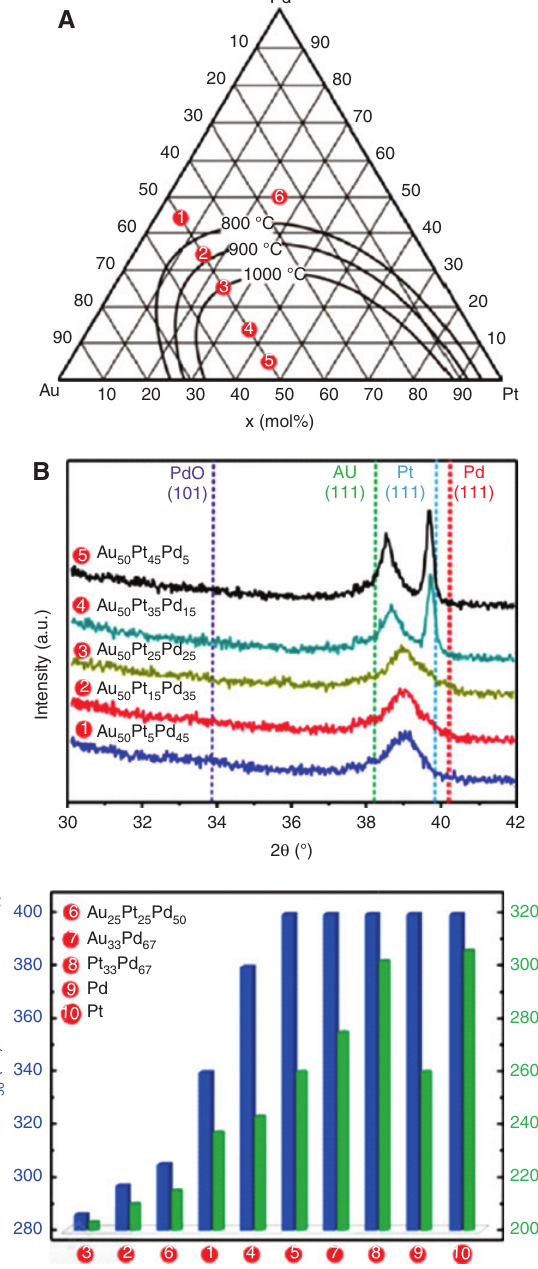
Figure 10: (A) Immiscible area isotherms of the bulk Au-Pt-Pd phase diagram. (B) XRD patterns of samples 1–5 annealed at 800 ° C. (C) The reaction temperatures for 50% ( T n -hexane for samples 1–6 (1 wt.%) and 7–10 (4 wt.%). Reproduced from [91] with permission from the Royal Society of Chemistry.